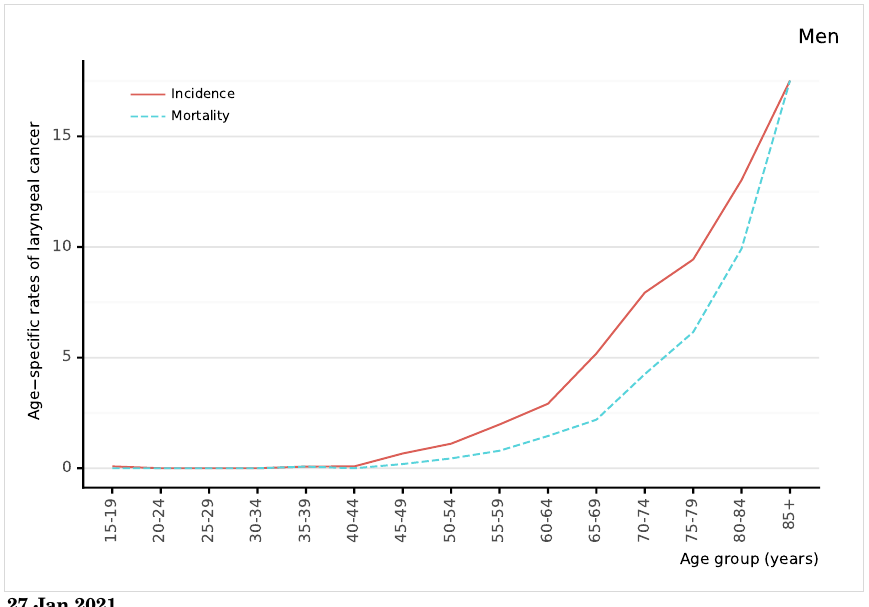
Figure 52: Comparison of age-specific laryngeal cancer incidence and mortality rates among men in Peru (estimates for 2020)